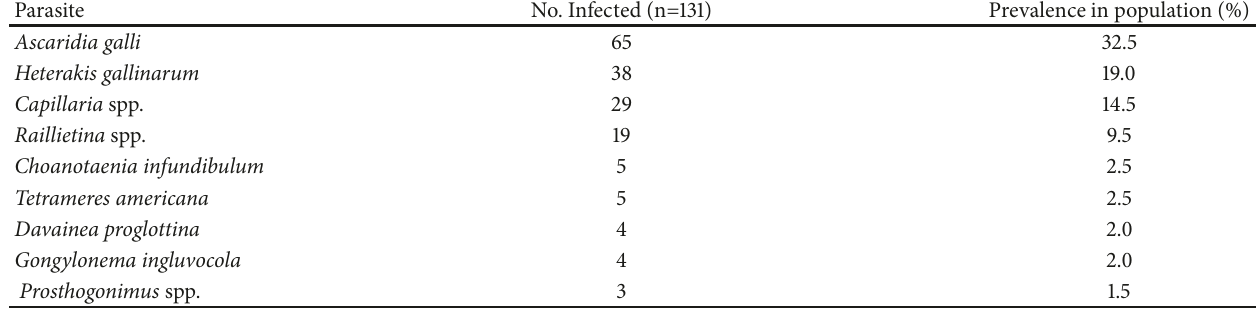
Table 1: Prevalence of gastro-intestinal helminths of local and exotic breeds of chicken in Pankrono- Kumasi Ghana.